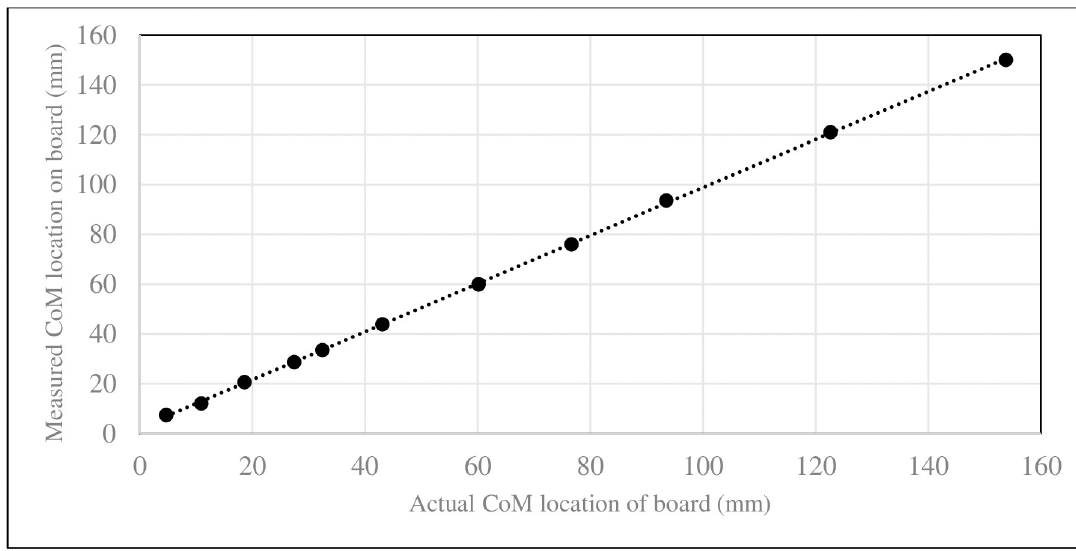
Fig 3. Calibration of the reaction board comparing the difference between the actual position of CoM of the calibrated 25-kg mass and the position measured by the reaction board.